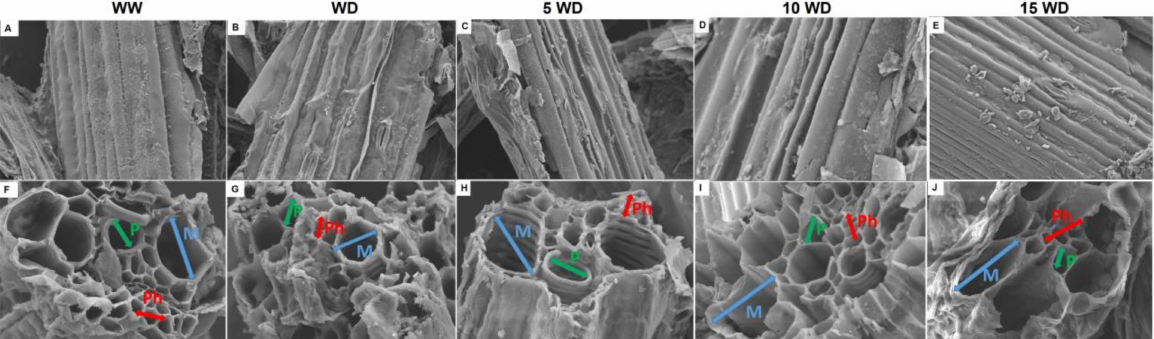
Figure 4. Effect of α Fe 2 O 3 NP priming on the anatomy of sorghum plants under drought stress: epidermis layers (( A – E ); magnification = 10 µ m); vascular bundle layers [metaxylem (M; blue), protoxylem (P; green), and phloem (Ph; red)] (( F – J ); magnification = 2 µ m). WW =well-watered (control); WD = water-deprived (drought stress); 5 WD = water-deprived + 5 mg/L α Fe 2 O 3 NPs; 10 WD = water-deprived + 10 mg/L α Fe 2 O 3 NPs, 15 WD = water-deprived + 15 mg/L α Fe 2 O 3